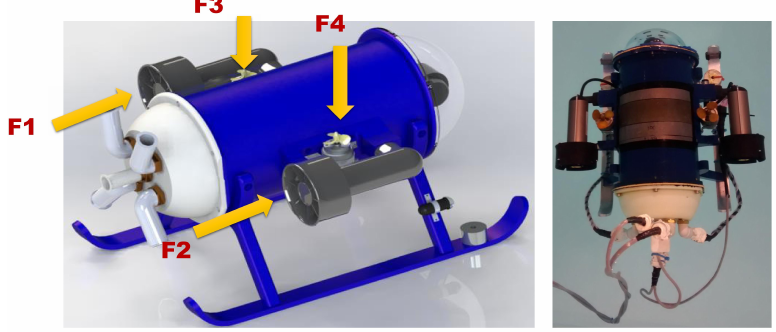
Figure 18. Thruster location.